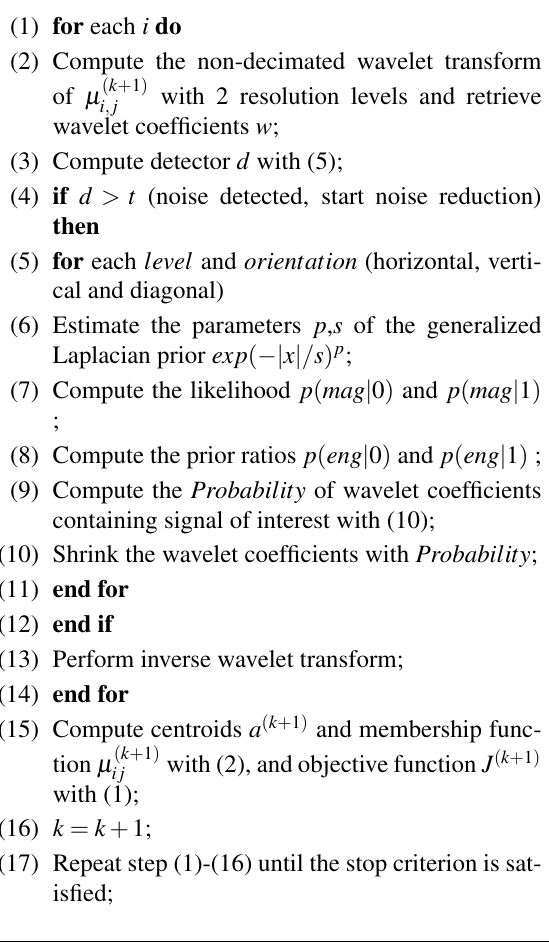
Algorithm 1. The proposed algorithm of dwFCM